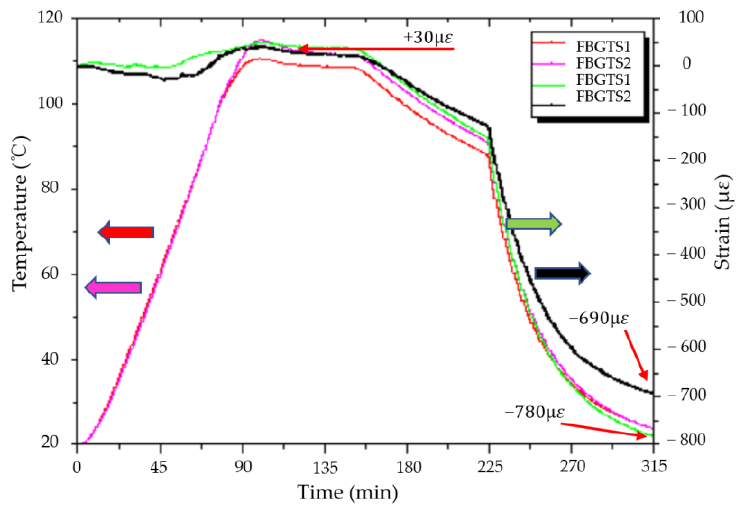
Figure 7. Temperature and strain history for the MCMHTs with and without pre-stretching during the co-cure bonding process.